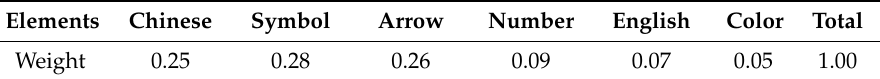
Table 1. Weight of six kinds of elements on road traffic